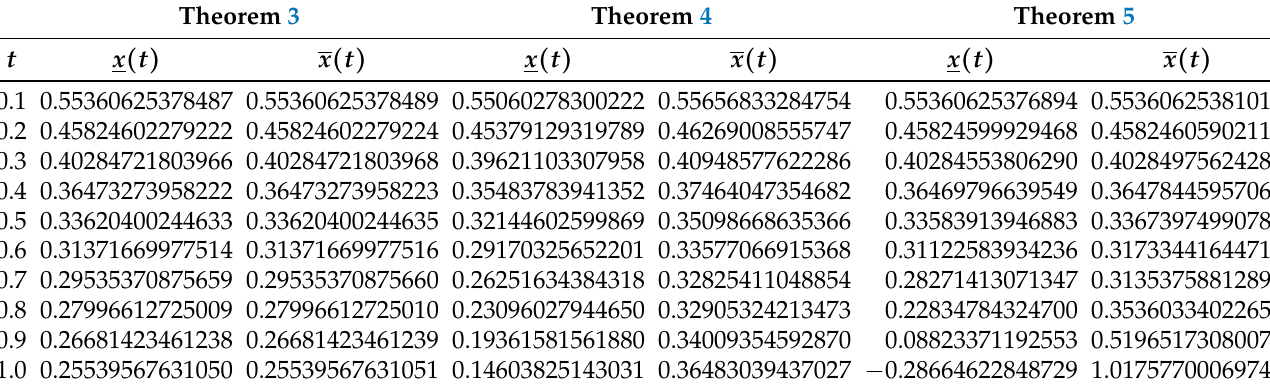
Table 1. Comparison of all verified solution techniques for the example